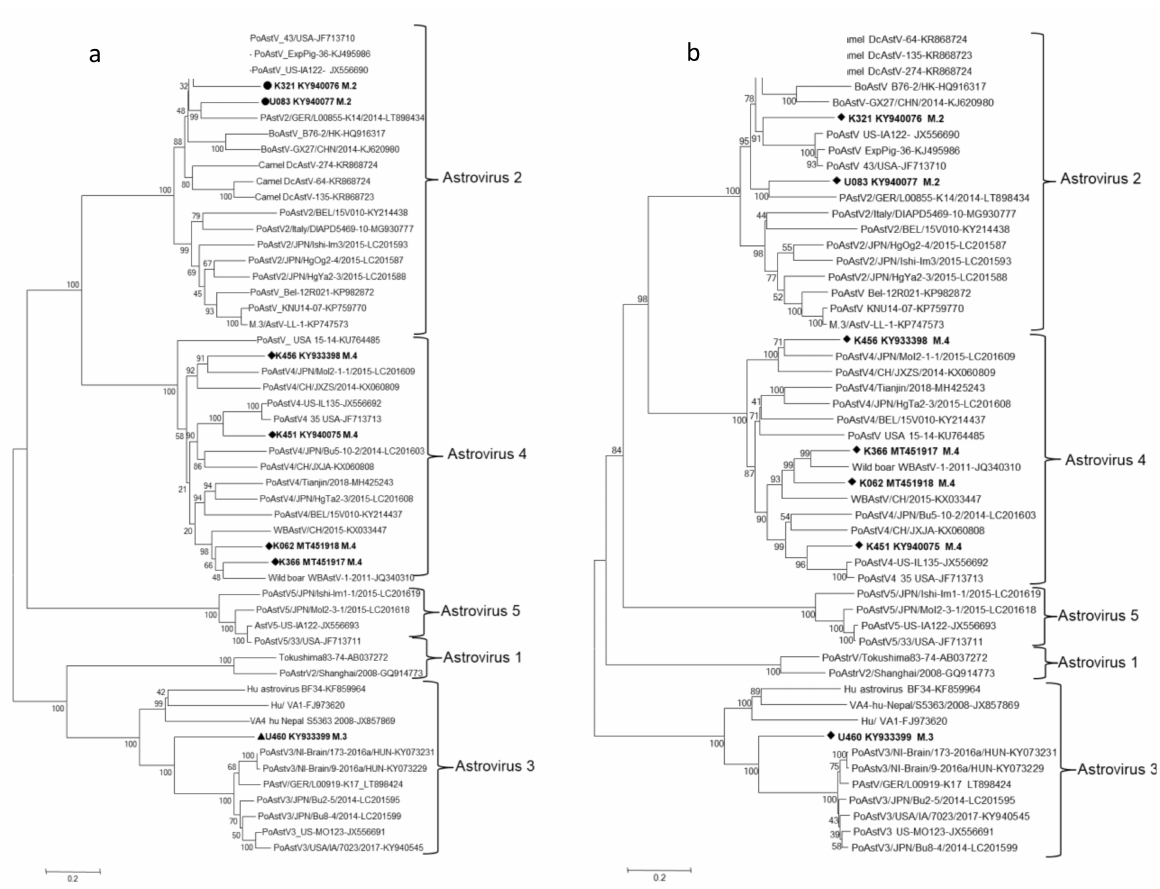
Figure 2. Phylogenetic tree based on the nucleotide ( a ) and amino acid ( b ) sequences of the capsid proteins (ORF2) of the East African astrovirus field strains and the known astroviruses in the GenBank. Multiple sequence alignments were performed using the ClustalO program. The evolutionary history was inferred by using the maximum likelihood method on the GTR model for nucleotide and neighbor-joining method using the p-distance substitution model for amino acid sequences in MEGA X [33]. The scale bar is given in numbers of substitutions per site. Phylogeny was inferred following 1000 bootstrap replications, and the node values show percentage bootstrap